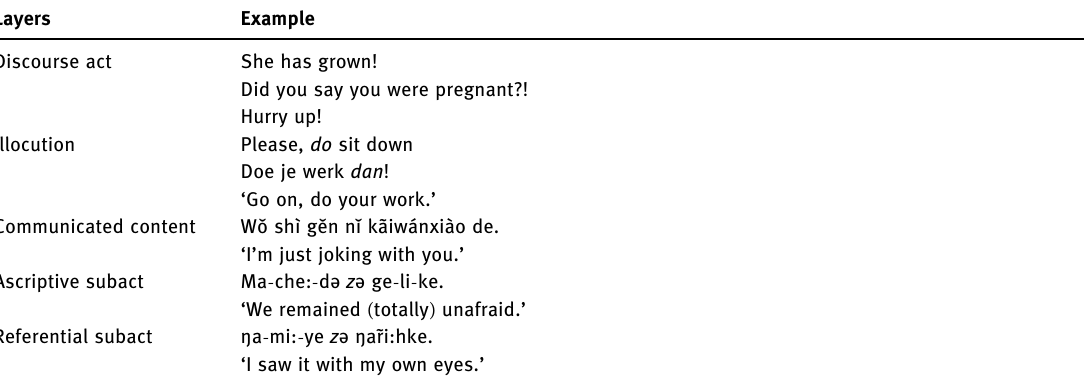
Table 3: Grammatical devices for Emphasis across Interpersonal layers